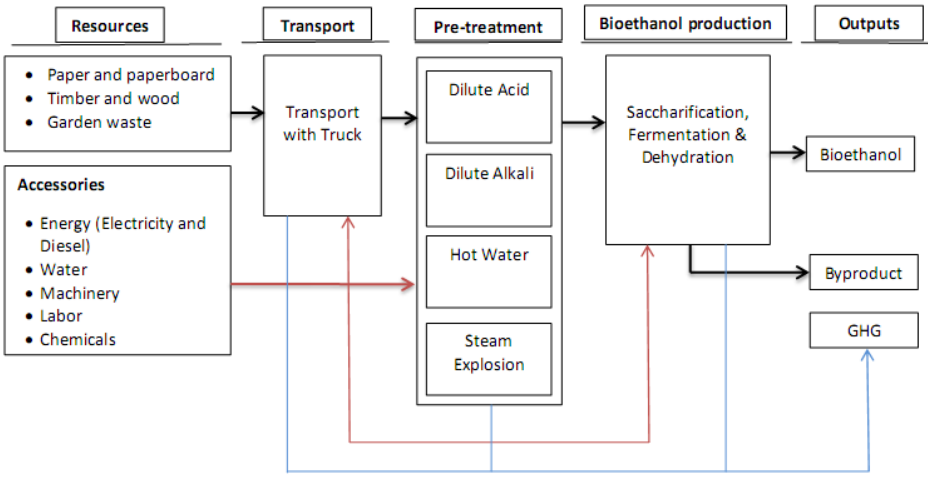
Figure 2. System boundaries considered by in this study including five stages of processes, conversion technologies and associated inputs (energy and material).